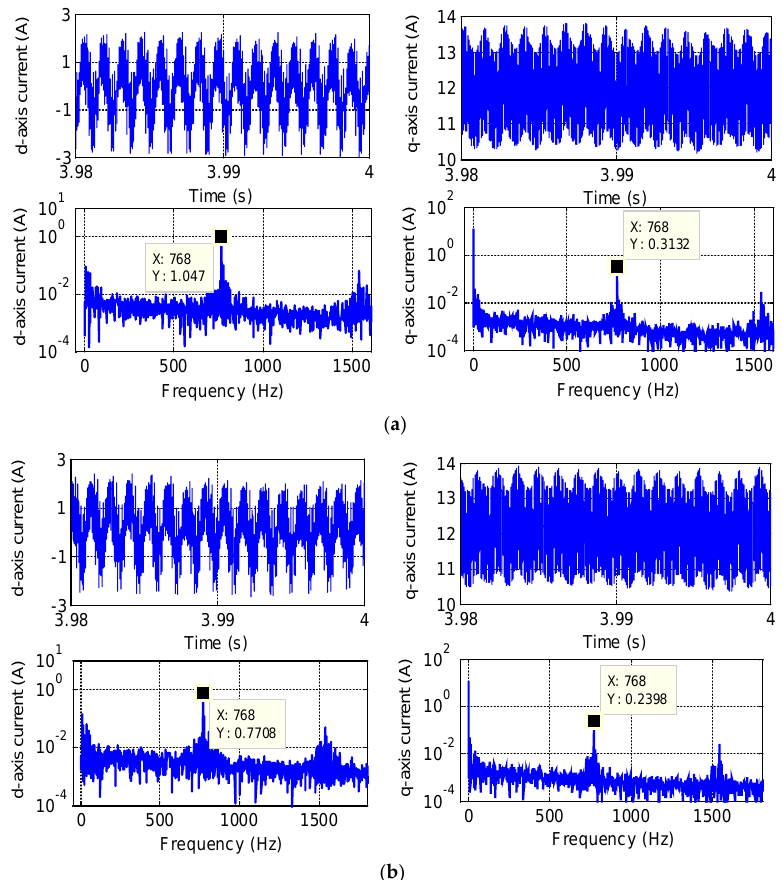
Figure 17. Waveforms and FFT results of d-axis and q-axis current at 1920 r/min: ( a ) Before suppression; ( b ) After suppression.